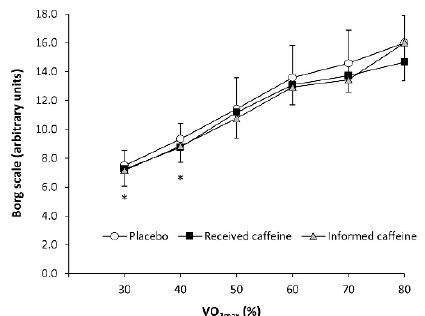
Figure 3. Rating of perceived exertion, measured with the Borg scale during an incremental step exercise test on a cycle ergometer in active individuals who ingested (1) a placebo; (2) three mg of caffeine per kg of body mass (received caffeine); and (3) a placebo, but they were told they were given three mg of caffeine per kg mass (informed caffeine). (*) Received caffeine different from placebo for the same workload at p < 0.050.